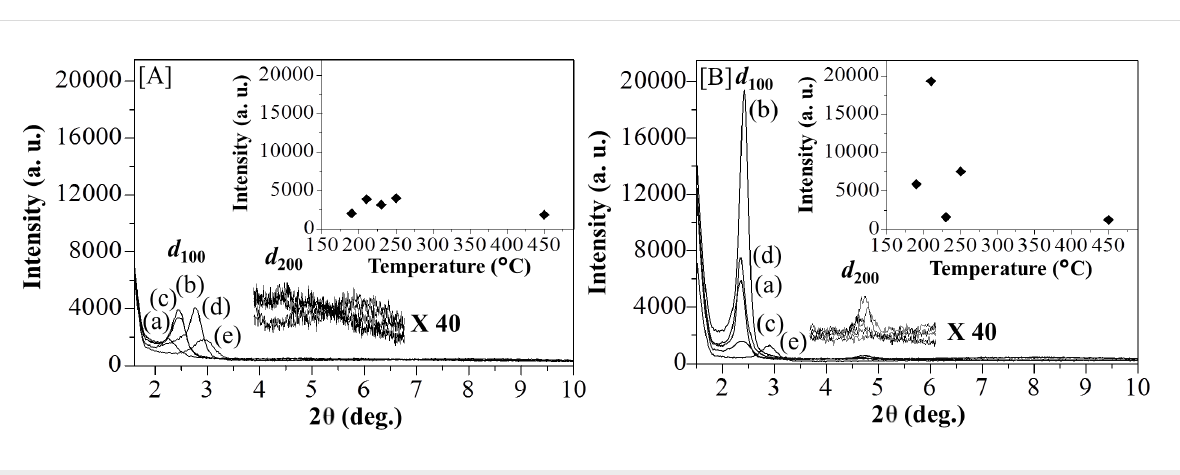
Figure 4: XRD patterns in the small-angle region of a) [AuNPs] cal /silica hex films after calcination and b) [AuNPs] red /silica hex films after the thermal hydrogen reduction at (a) 190, (b) 210, (c) 230, (d) 250 and (e) 450 °C, where the inset graphs shown the XRD peaks of the maximum intensity of d 100 versus temperature.